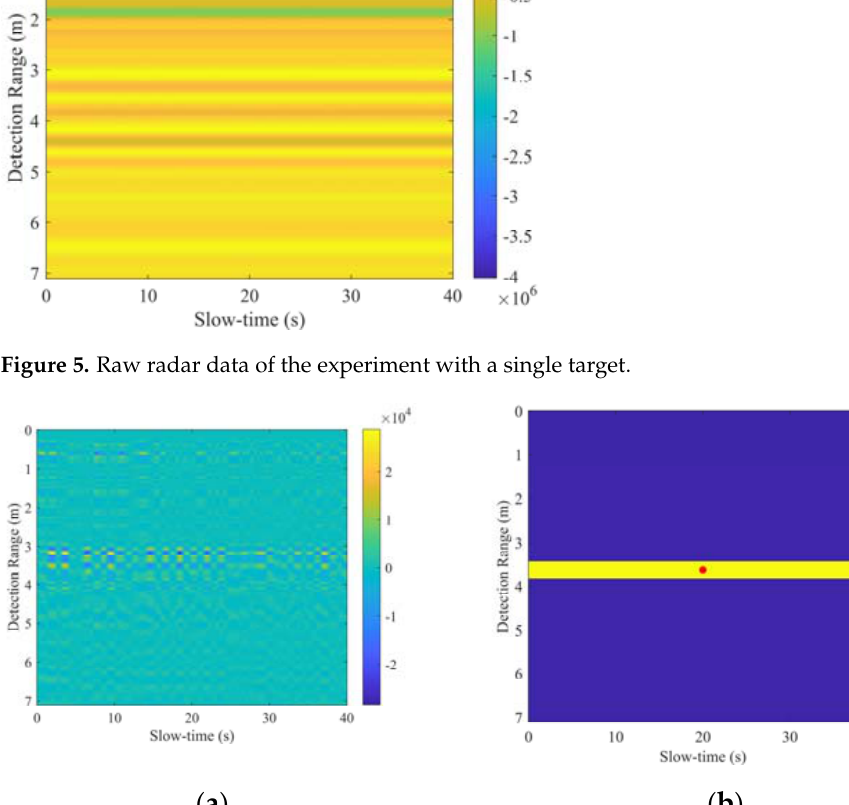
Figure 6. Results of the experiment with a single target: ( a ) range-slow-time matrix obtained after step A; ( b ) TPOIs extracted by CNN.